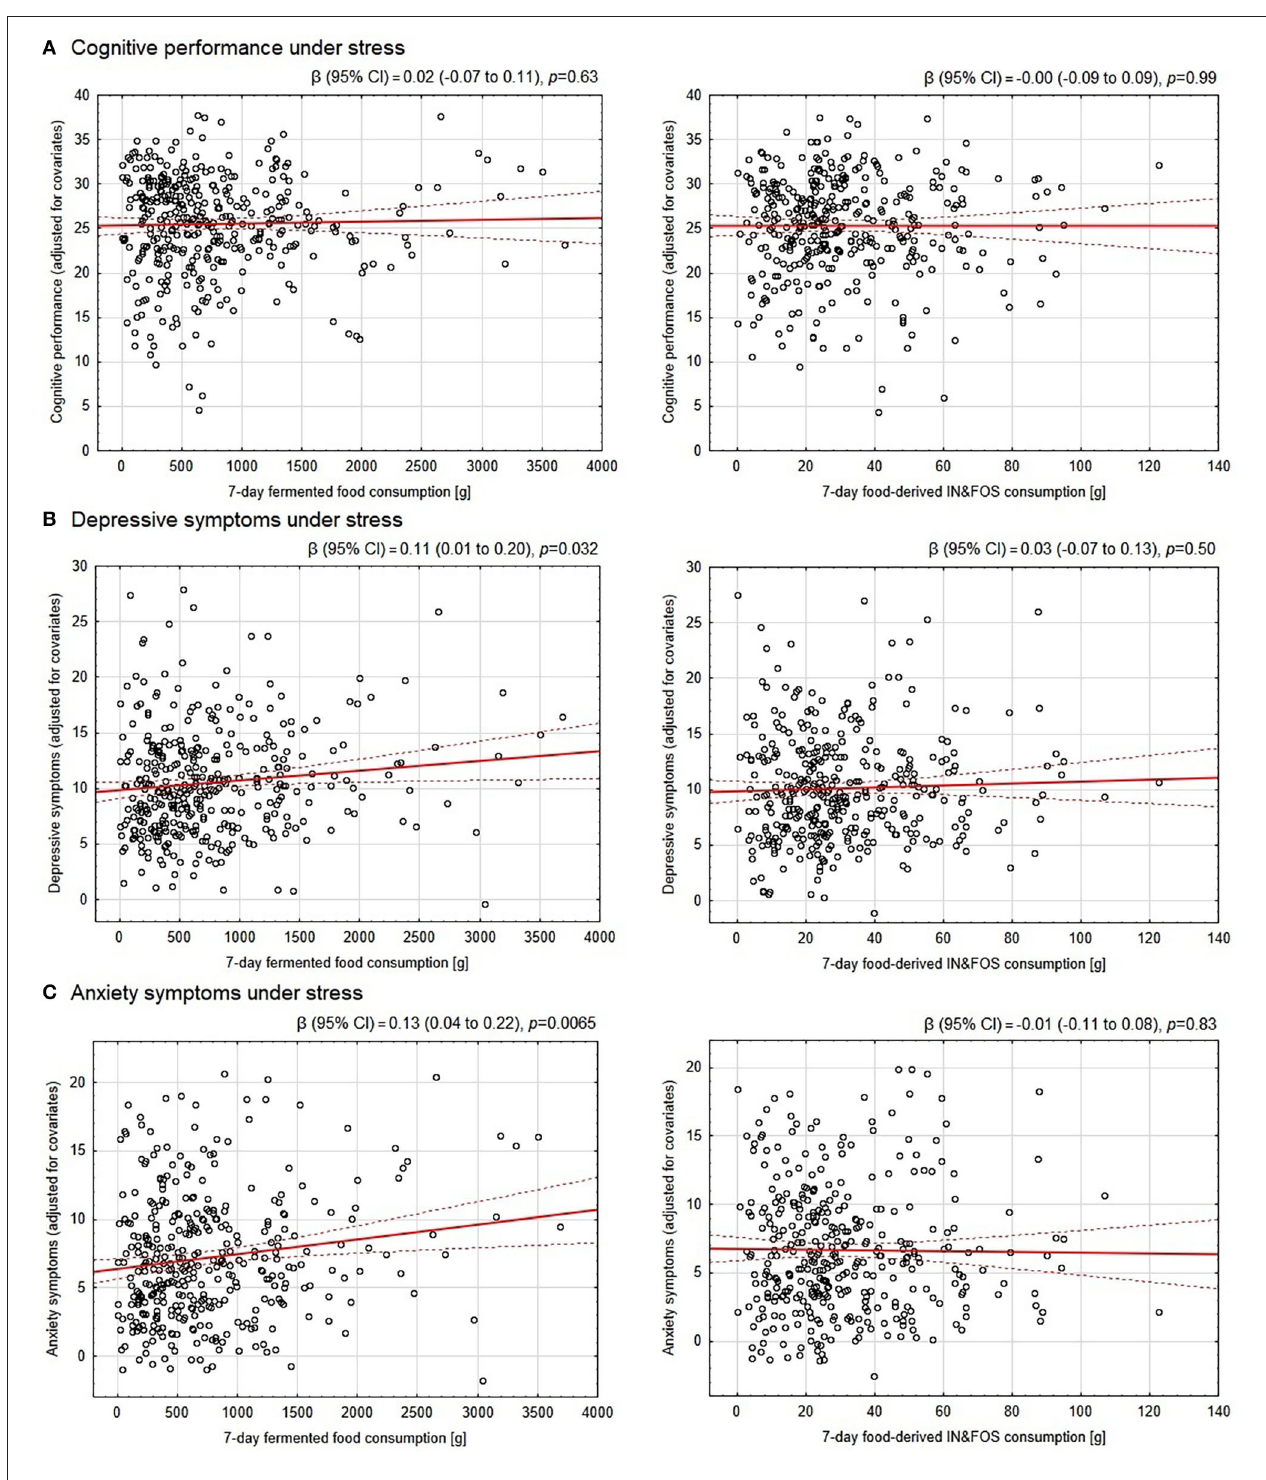
FIGURE 2 | Association between the 7-day consumption of fermented food and food-derived prebiotics with cognitive performance, depressive and anxiety symptoms under psychological stress. The OY axes of the scatter plots represent: (A) scores in the final exam adjusted for subject knowledge assessed a day before the final exam under non-stressful conditions as well as the final exam round (cognitive performance under stress) and further adjusted for covariates, (B) pre-exam Patient Health Questionnaire-9 scores (depressive symptoms) adjusted for covariates, (C) pre-exam Generalized Anxiety Disorder-7 scores (anxiety symptoms) adjusted for covariates. The covariates included in the analyses were: sex, socioeconomic status, number of inhabitants in a place of family residence, BMI, current